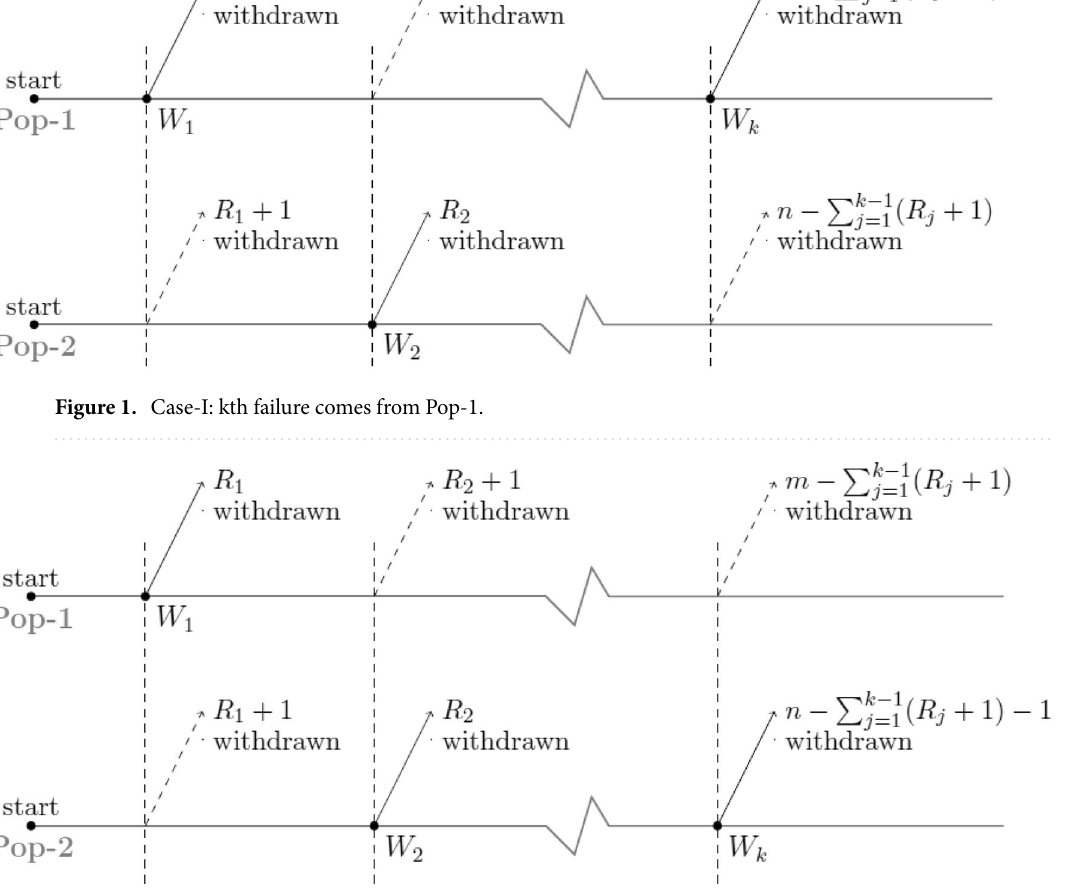
Figure 2. Case-II: kth failure comes from